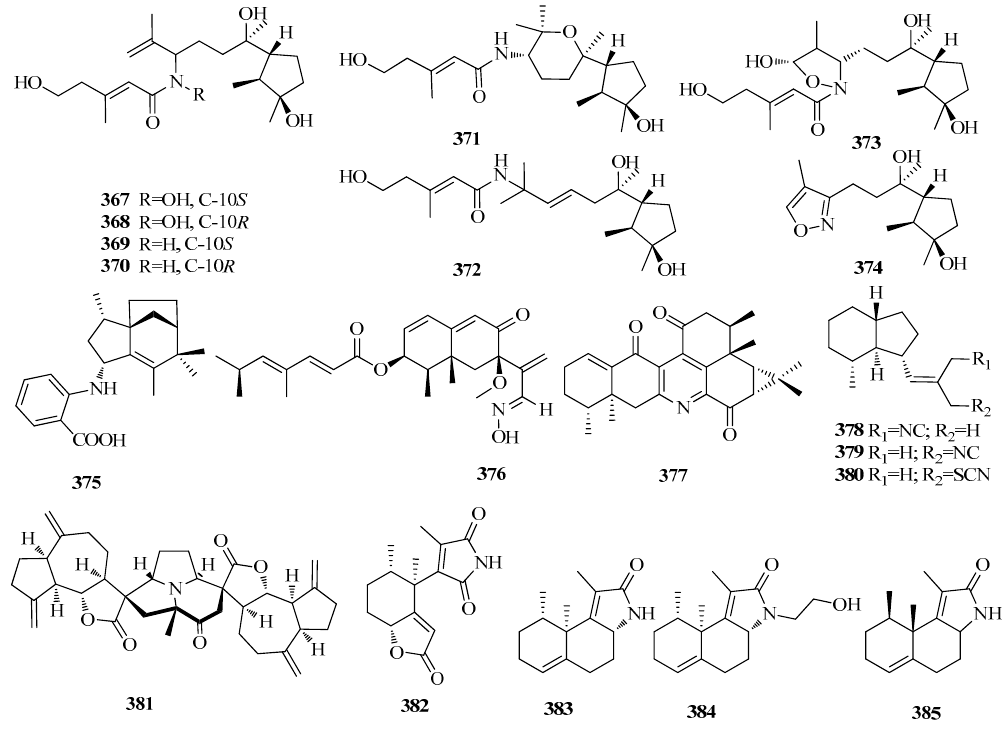
Figure 11. The structures of compounds 367 – 385.